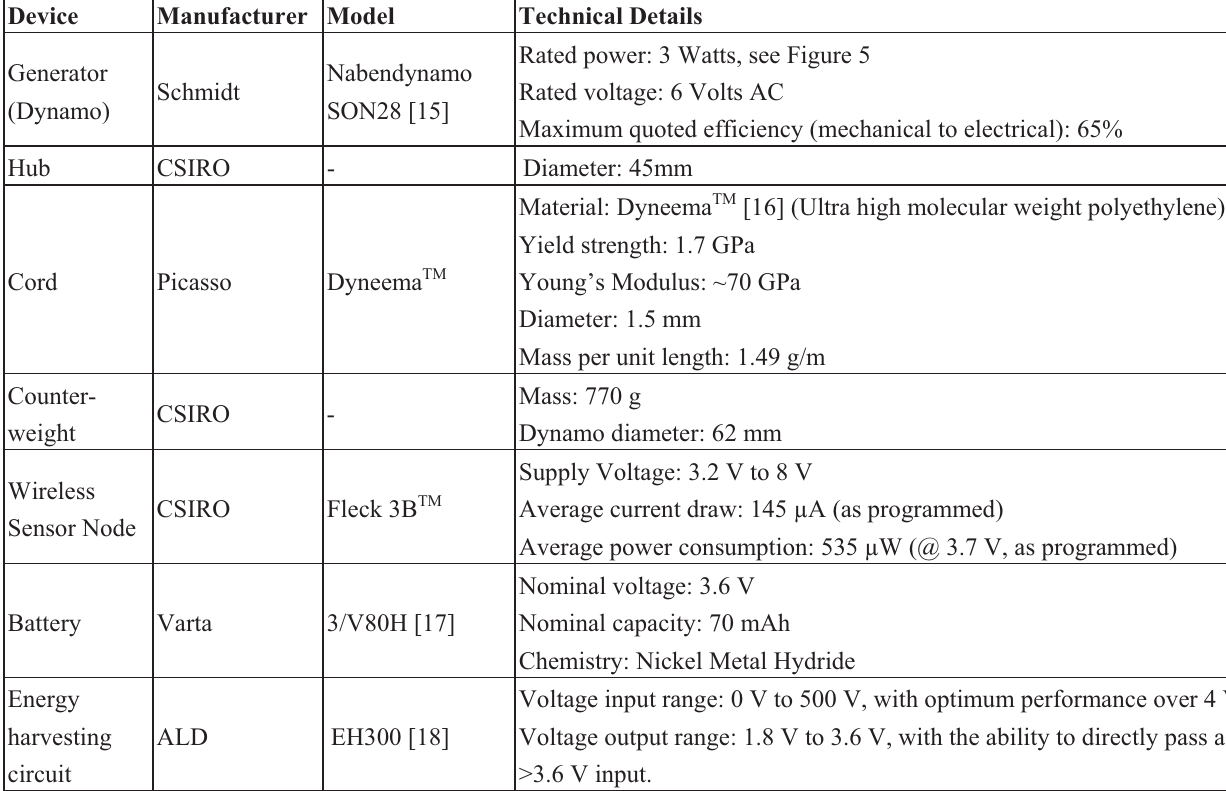
Table 1. Tree Movement Energy Harvester Technical Information.